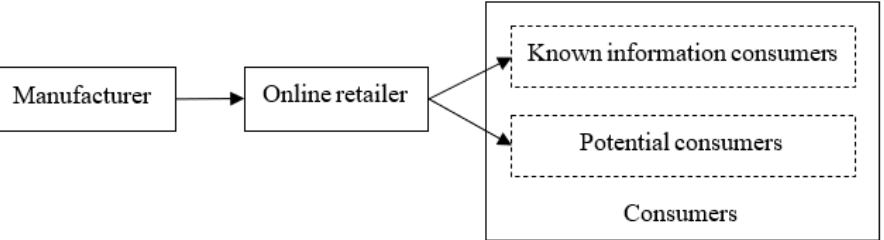
Figure 1. The structure of the green supply chain.